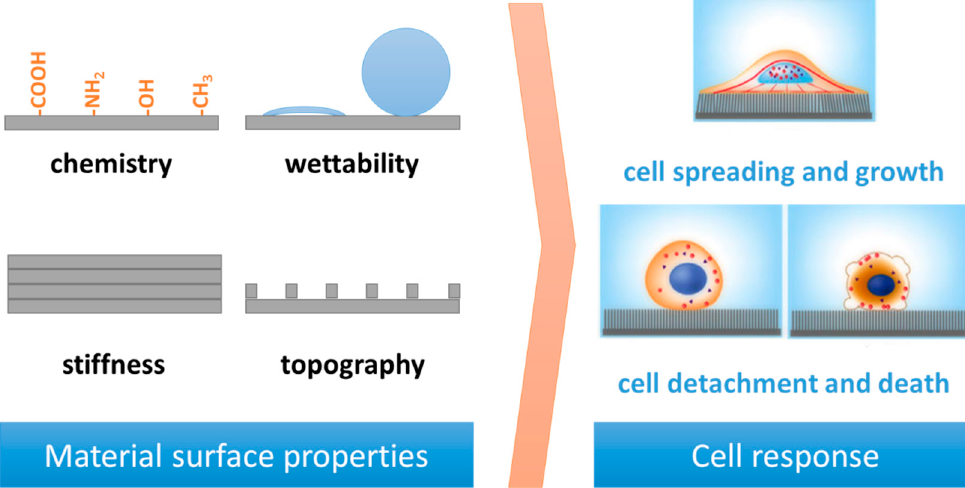
Figure 1. Schematic representation of the main surface properties and their direct effect on cell behavior.